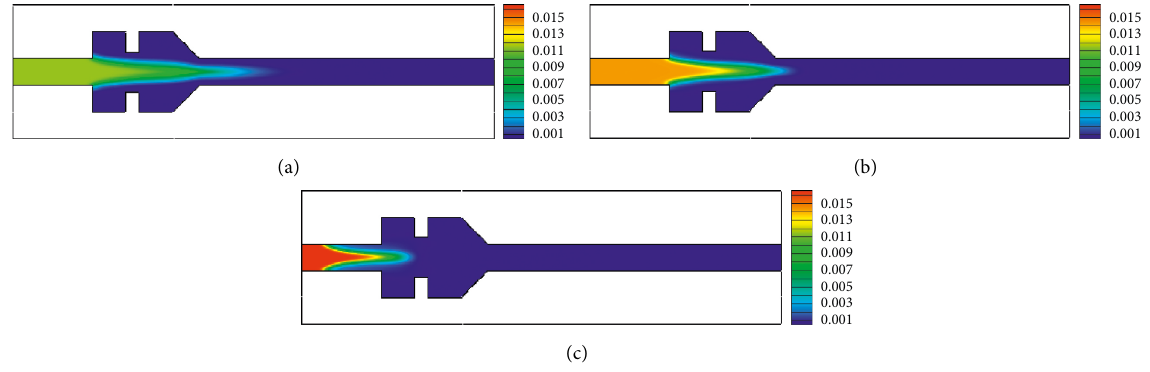
� 0.4, (b) Φ � 0.5, and (c) Φ �